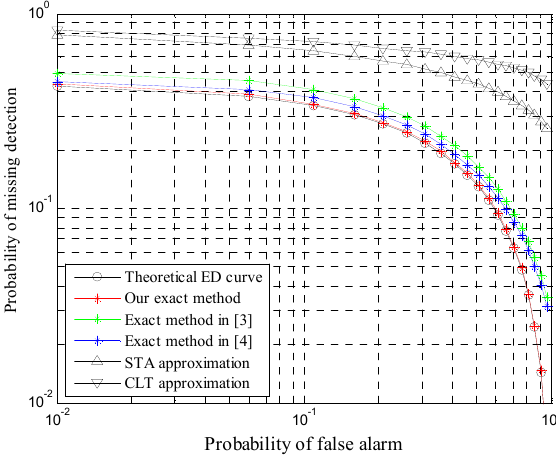
Figure 1. CROC curves for γ = 0 dB, α = 2, µ = 1.